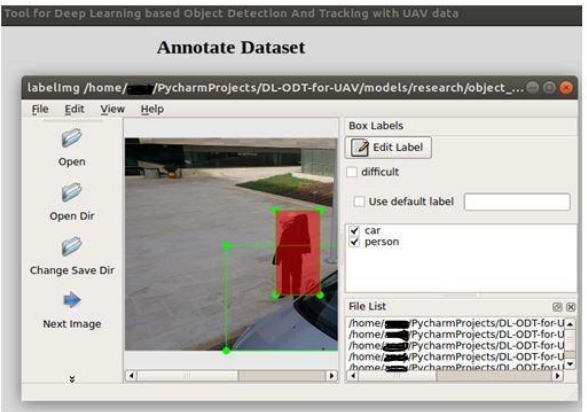
Figure 10. LabelImg annotator